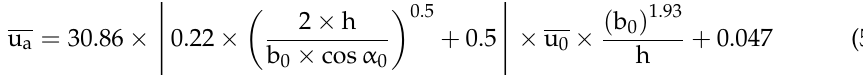
Figure 15. Least square fit for the test results with Re < 3820.